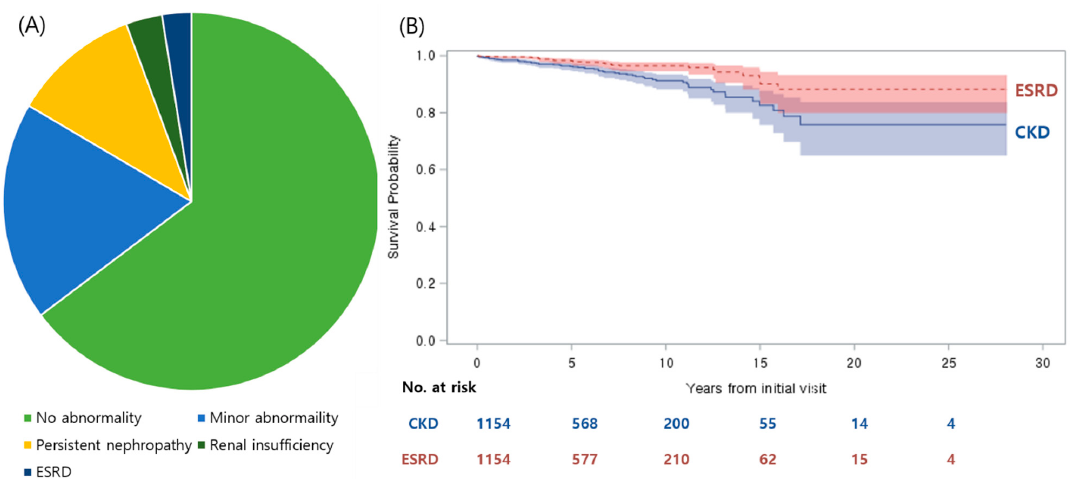
Figure 1. Final outcomes of Immunoglobulin A nephropathy (IgAN) patients at final follow-up visit. ( A ) Five categories of renal outcomes. ( B ) CKD–free and end–stage renal disease (ESRD)–free survival rates for all enrolled patients. CKD: chronic kidney disease stage 3–5.